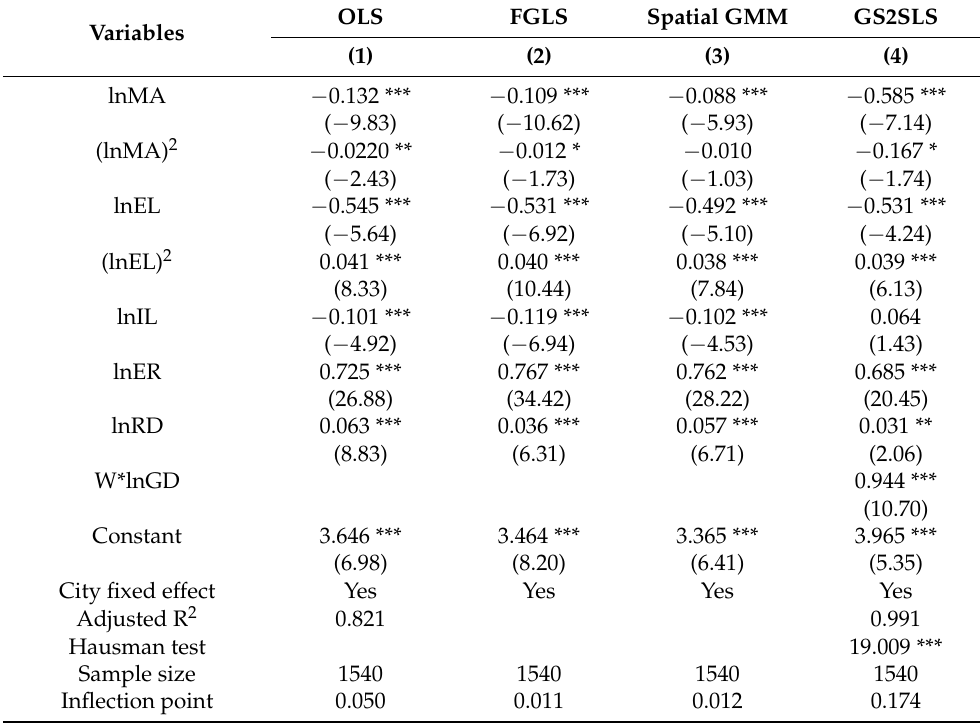
Table 2. Estimation results of impact of MA on